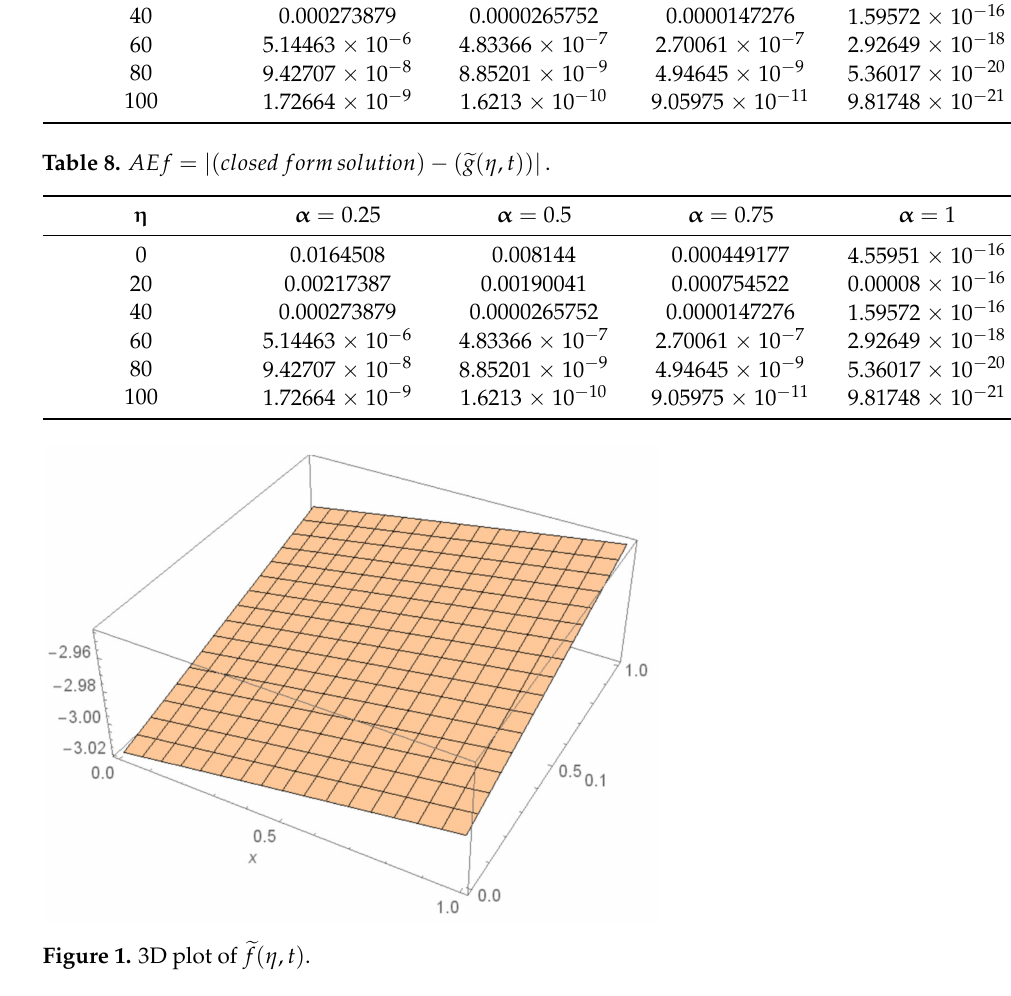
(cid:17)(cid:12) (cid:12) (cid:12) .